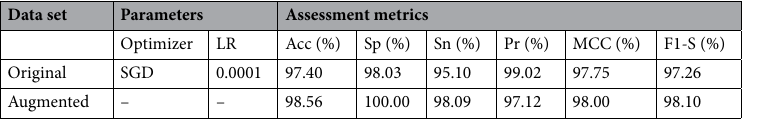
Table 1. CNN model performance on original and augmented data